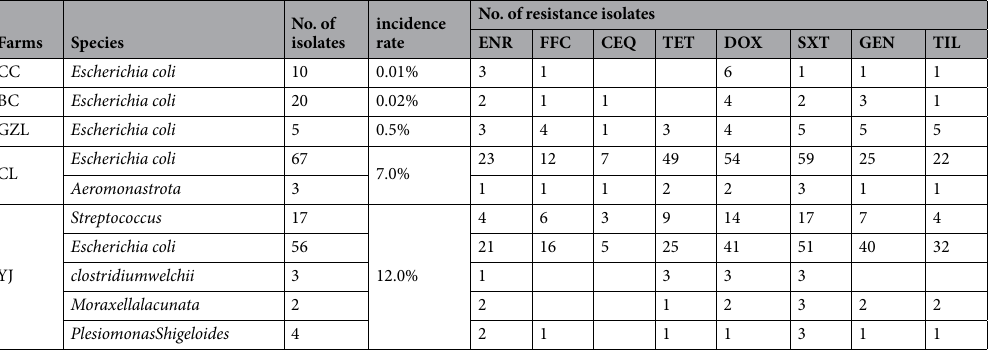
Table 1. In vitro susceptibility of clinical isolatesoffive farms and morbidityofincidencerate. ENR, enrofloxacin; FFC, florfenicol; CEQ, cefotaxime; TET, tetracycline; DOX, doxycycline; SXT, sulfamethoxazole/trimethoprim. GMS, gentamicin; TIL, tilmicosin.